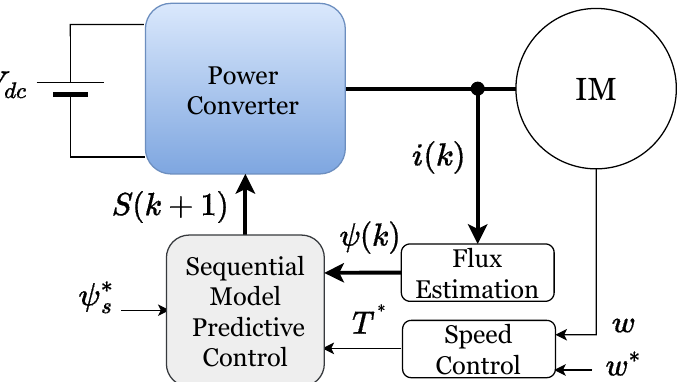
Figure 3. General scheme of the proposed sequential model predictive control (SMPC) for motor drive